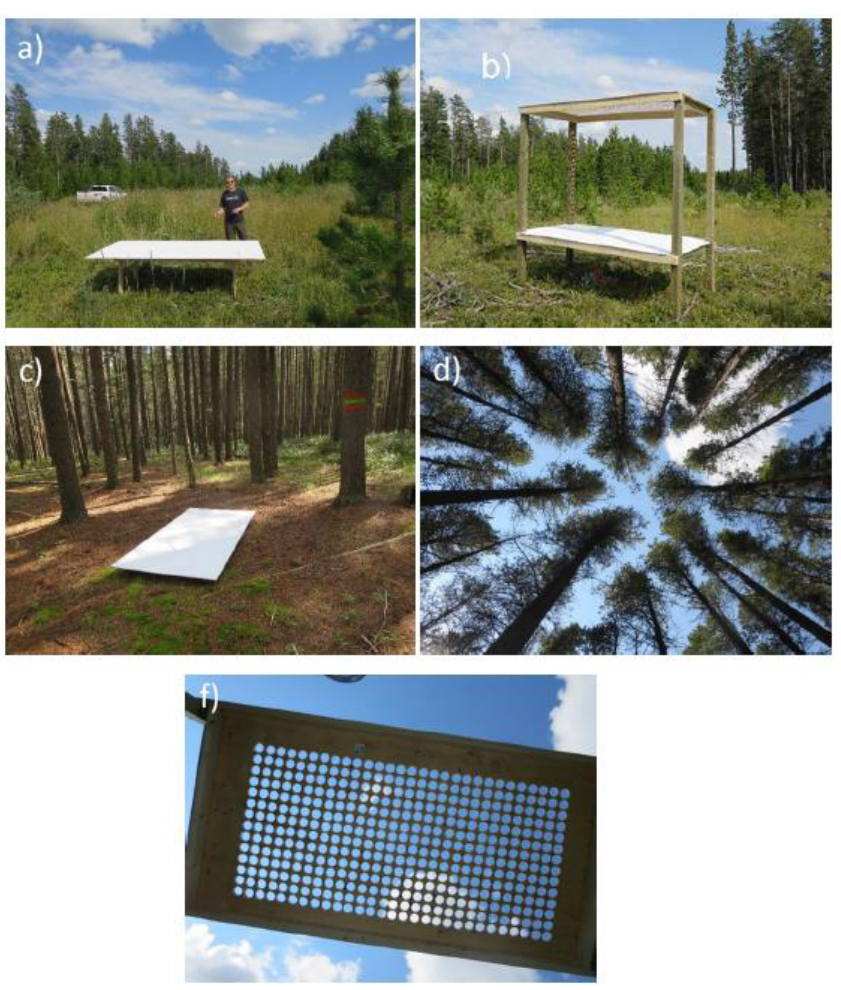
Figure 1. Photos of the radiometric calibration targets (made from 8′ by 4′ plywood). Photos ( a ), ( b ), and ( c ) are an open target, lifted target, and below-canopy target, respectively. Photos ( d ) and ( f ) illustrate corresponding transparency of the Lodgepole Pine foliage above the target and transparency of the lifted target.